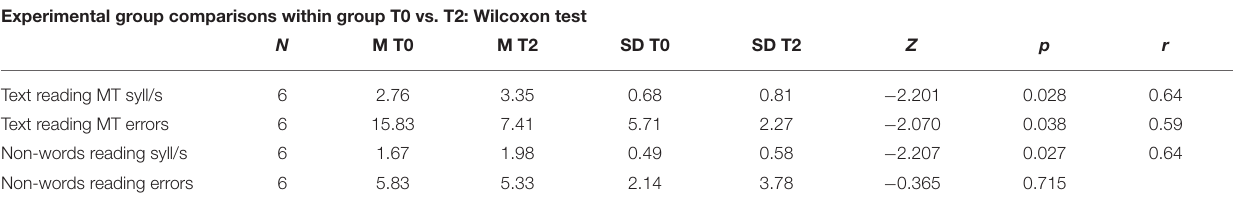
TABLE 8 | Experimental group, comparisons within group, calculated on Wilcoxon test for two dependents groups; number of subjects ( N ), mean pre and post training (M T1 and M T2), standard deviation (SD), Z -value of Wilcoxon ( Z ), p -value ( p ), effect size ( r ). Experimental group; comparisons within group T1 vs. T2, Wilcoxon test N M T1 M